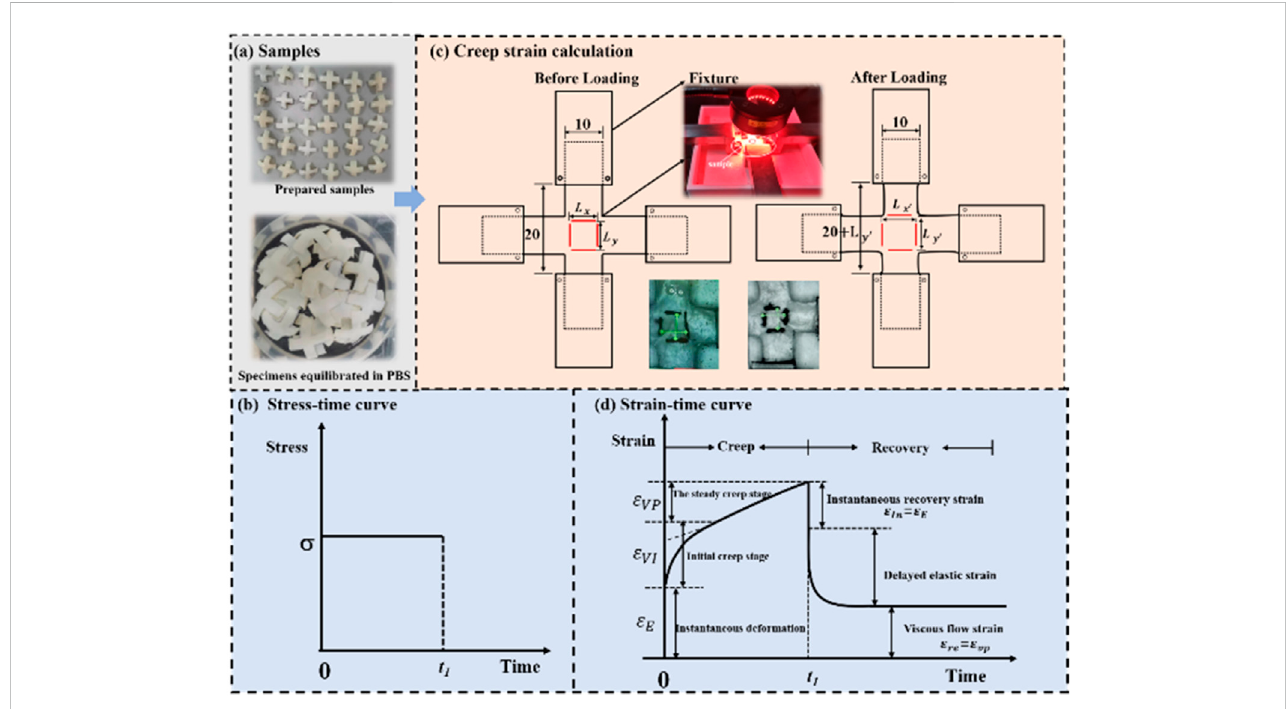
FIGURE 2 (A) Samples; (B) stress-time curve; (C) creep strain calculation; (D) stress-time